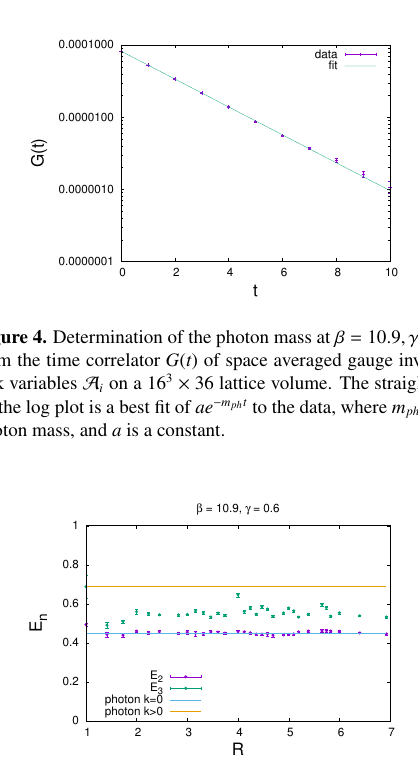
Figure 5. Energies E n ( R ) vs. R for n = 2 , 3 again at γ = 0 . 60 on a 12 3 × 36 lattice volume. The lower solid line represents the mass of a massive photon, and the upper line is the energy of a massive photon at the lowest possible momentum on this finite periodic